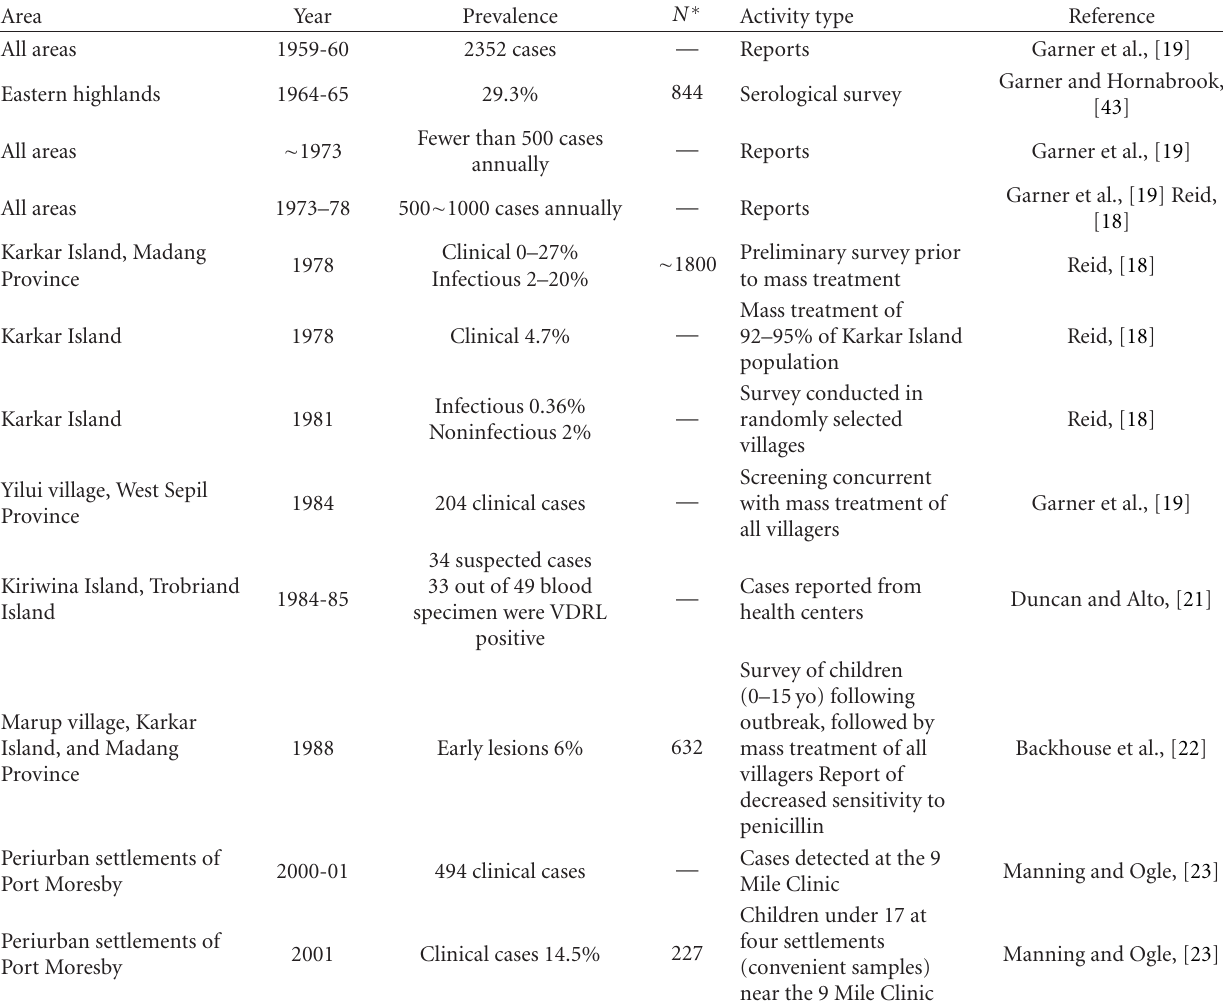
Table 3: Summary of yaws reported cases and prevalence surveys in PNG since